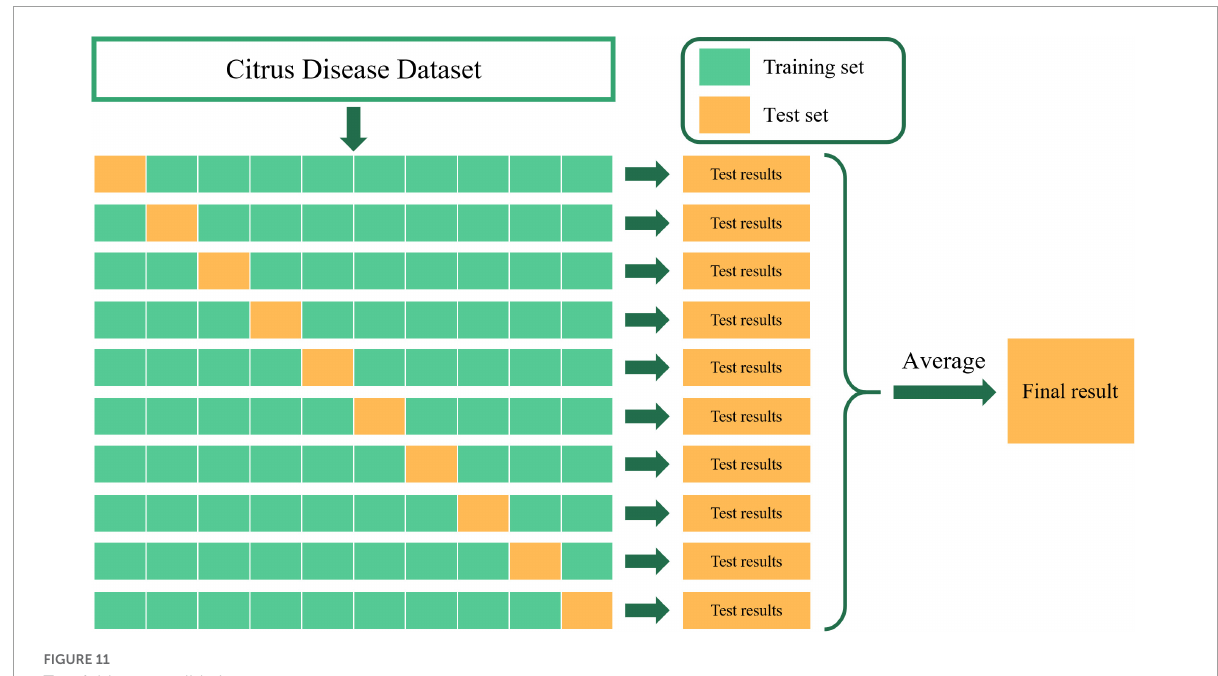
FIGURE11 Ten-fold